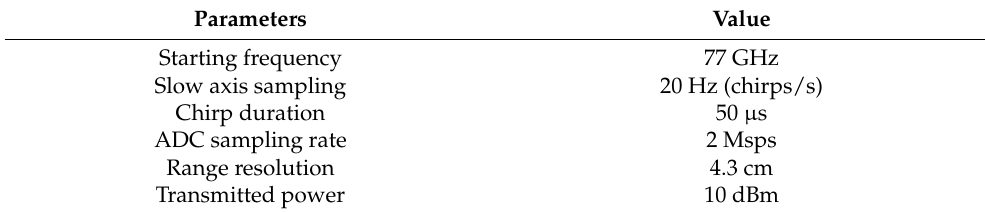
Table 1. Vital signs measurement parameters.